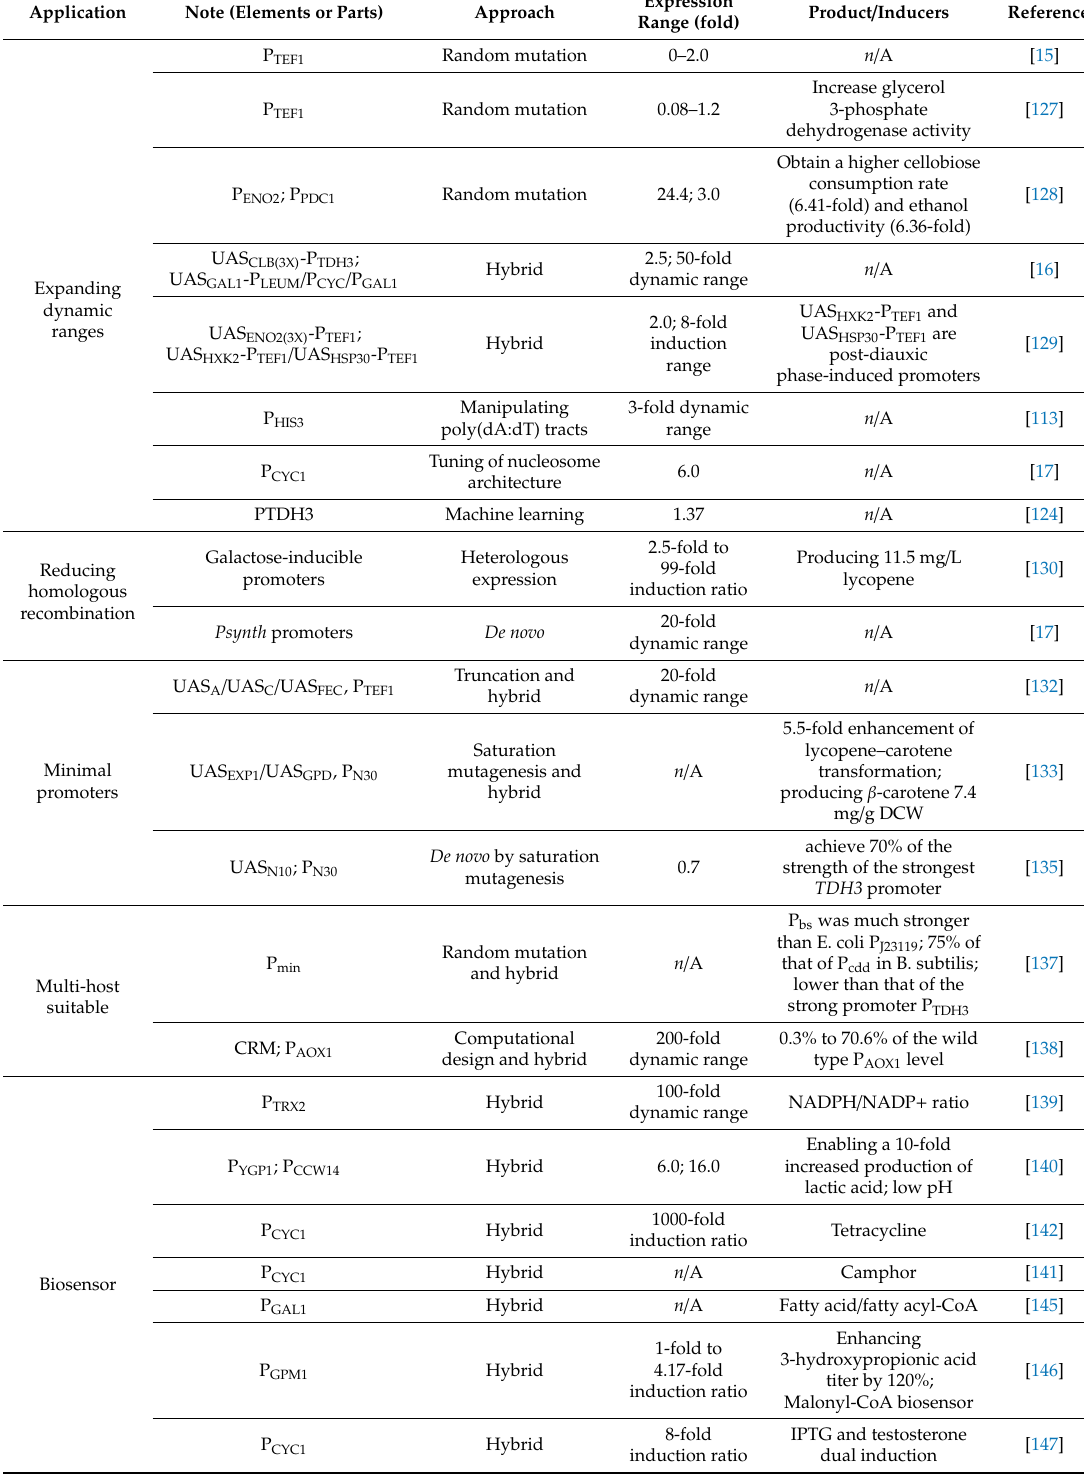
Table 2. The characteristics of engineered